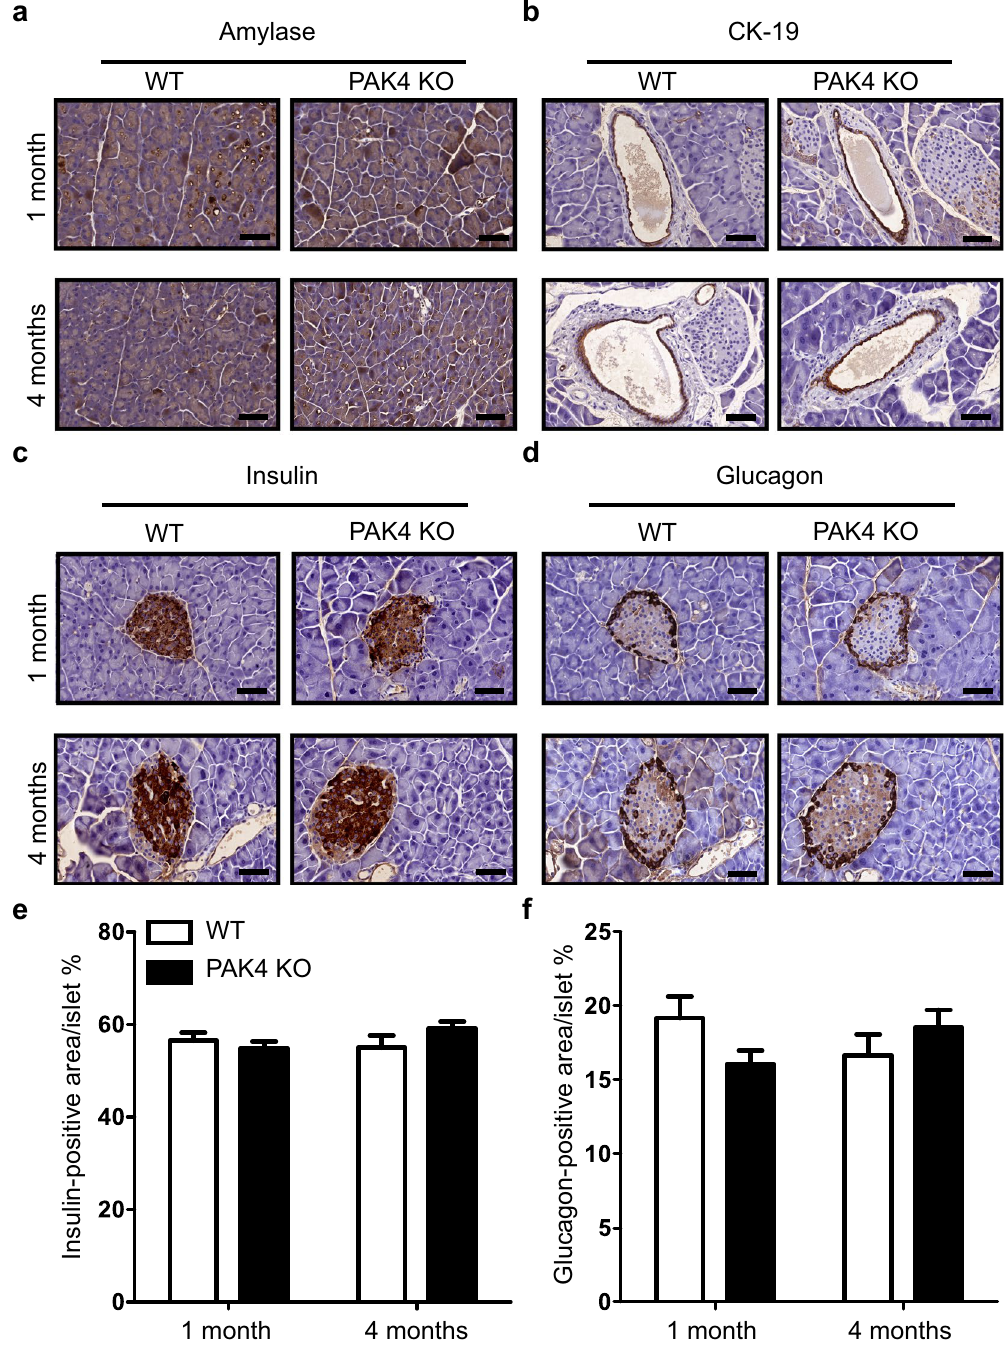
Figure 3. Normal occurrence of the various cell types in exocrine and endocrine pancreas upon conditional PAK4 depletion. ( a , b ) Immunohistochemical staining for the exocrine markers amylase (a) and CK-19 ( b ) in pancreas from WT and PAK KO mice of one and four months of age. Scale bars: 60 μ m (c-d) Two adjacent pancreatic sections from 1 and 4 months old WT and PAK KO mouse pancreas were stained with anti-insulin ( c ) and anti-glucagon ( d ) antibodies, respectively. Scale bars: 40 μ m ( e ) Morphometric data of the Insulin- stained islet area. Data are expressed as the mean ± SEM. T-test revealed no discernible differences between the genotypes. 1 month (p = 0.4706, n = 3) and 4 months (p = 0.1525, n = 3–4). ( f ) Morphometric data of the Glucagon-stained islet areas. Data are showed as the mean ± SEM. T-test revealed no discernible differences between the genotypes. 1 month (p = 0.1094, n = 3–4) and 4 months (p = 0.3168, n =